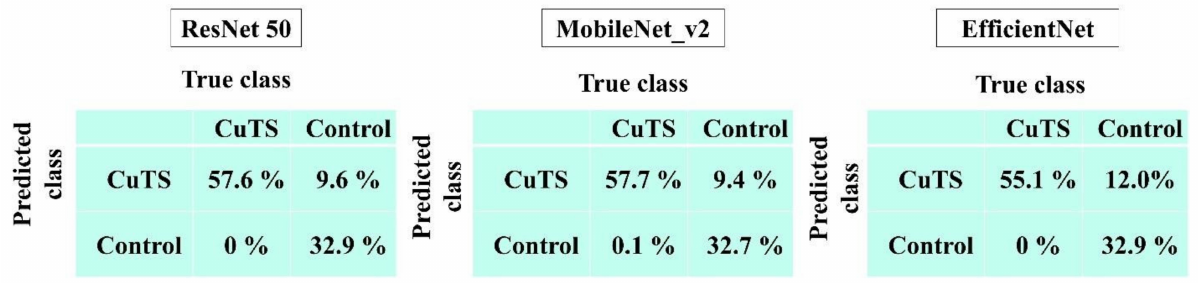
Figure 9. Confusion matrix of each learning